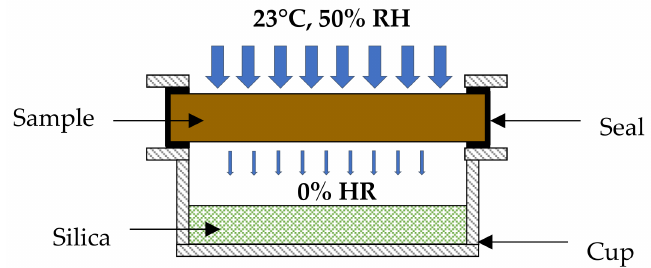
Figure 2. Dry cup device for measuring water vapor